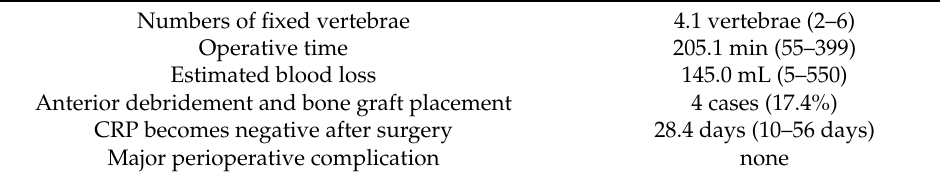
Table 4. Perioperative